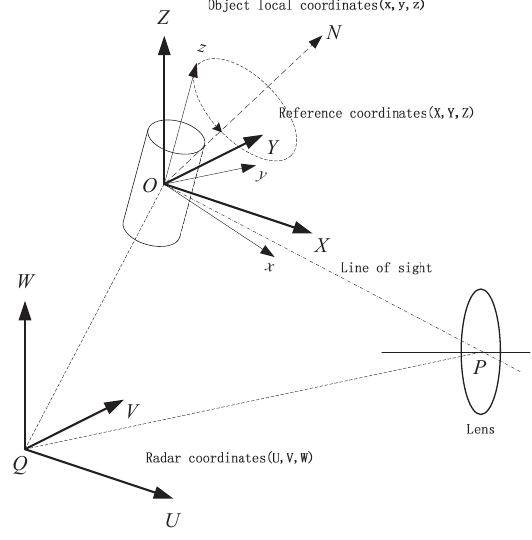
Figure 4. Geometry of radar, sensor and coning